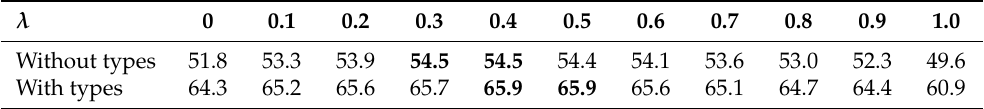
Table 3. Top-1 accuracy (%) with different λ values. The bold indicates the best results.